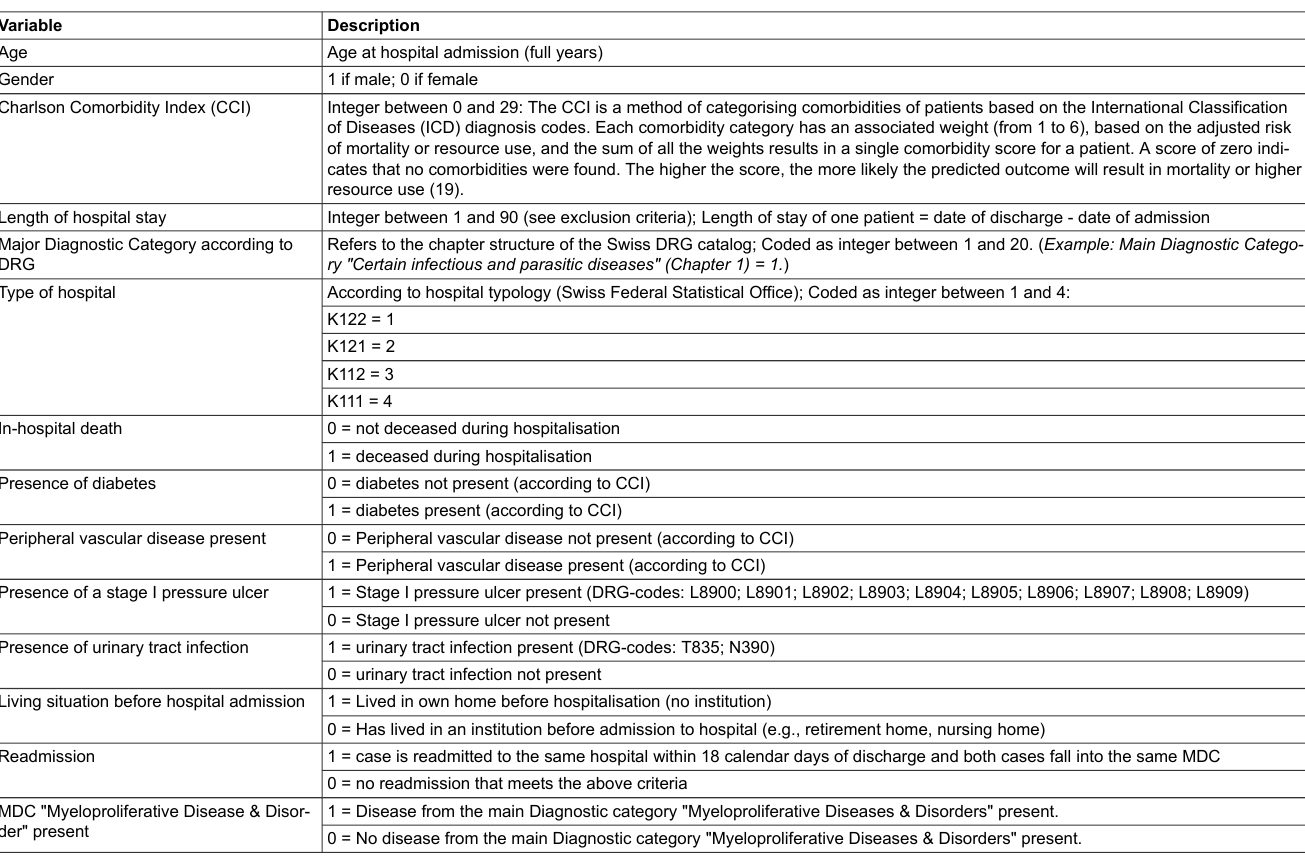
Table S1: Covariates